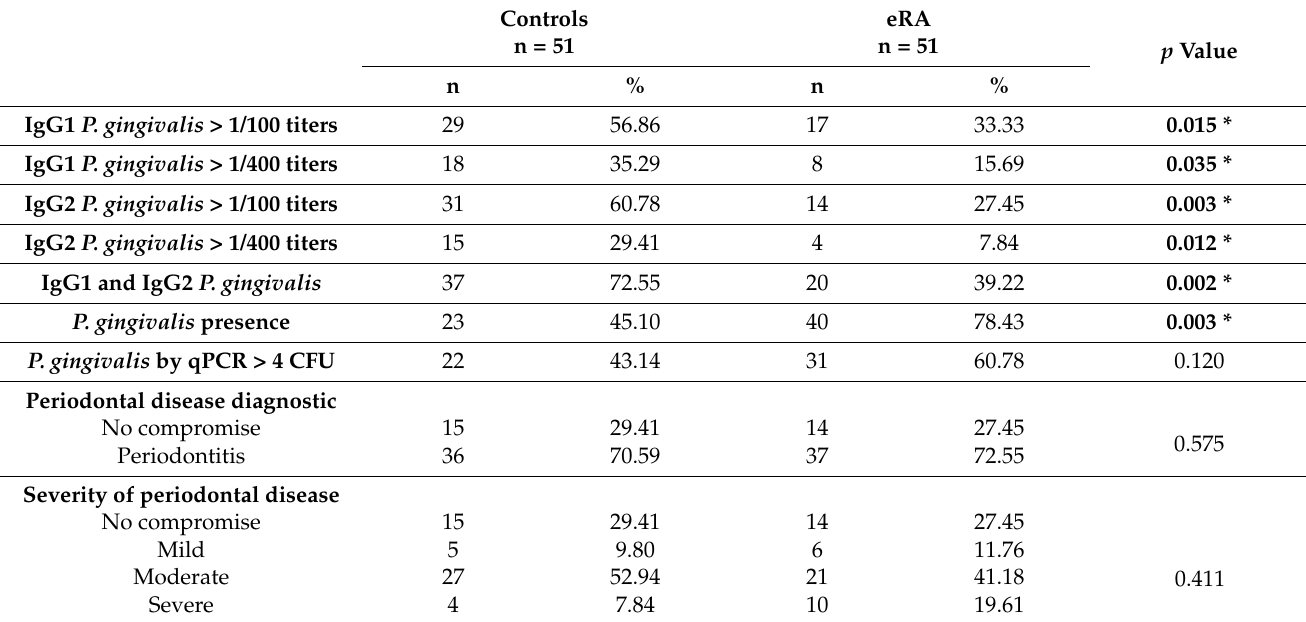
Table 2. Periodontal condition of patients with eRA and controls.